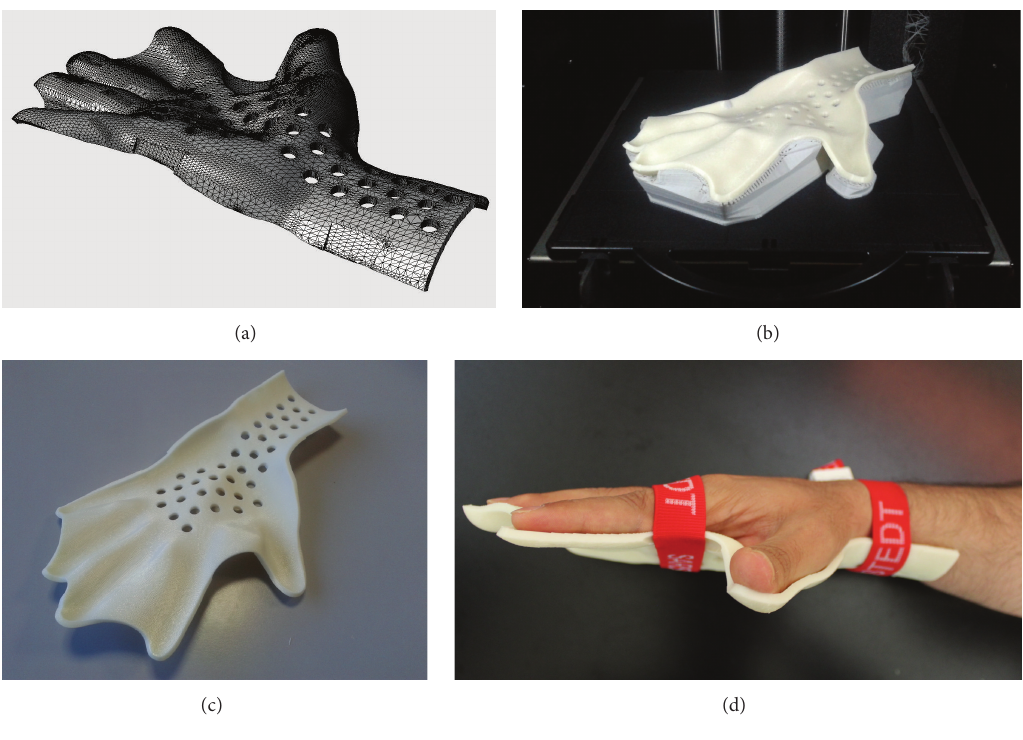
Figure 3: The 3D printing